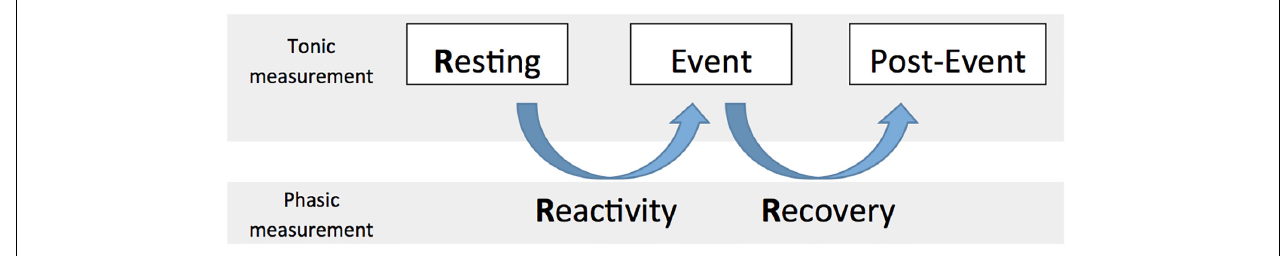
FIGURE 2 | The 3 Rs of cardiac vagal control: Resting, Reactivity, and Recovery.